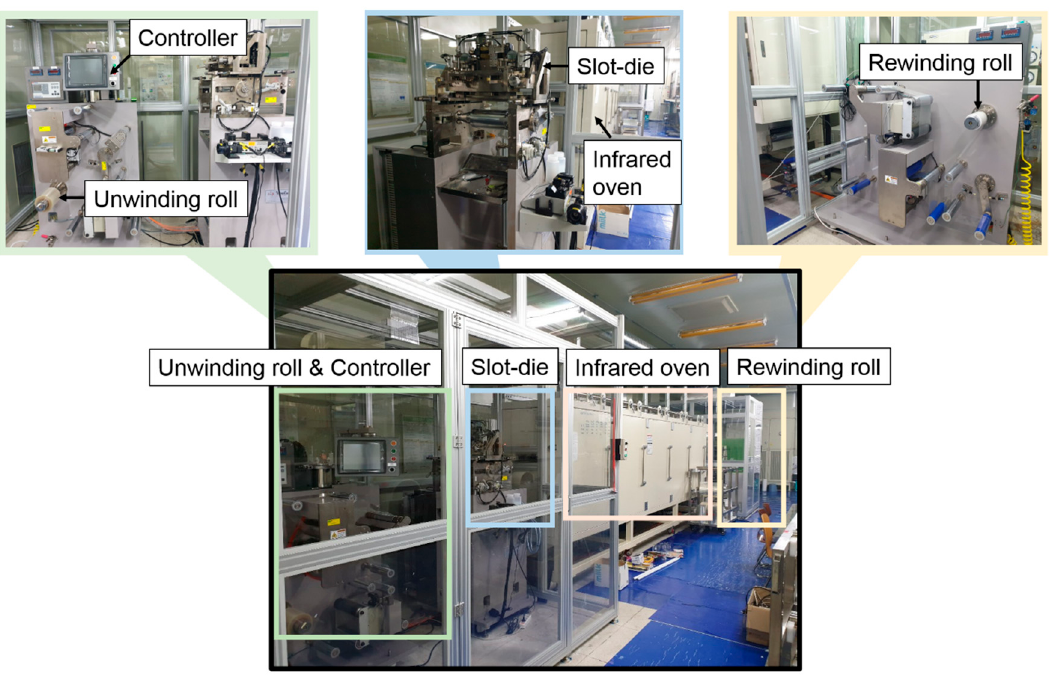
Figure 3. Roll-to-roll slot-die coater.